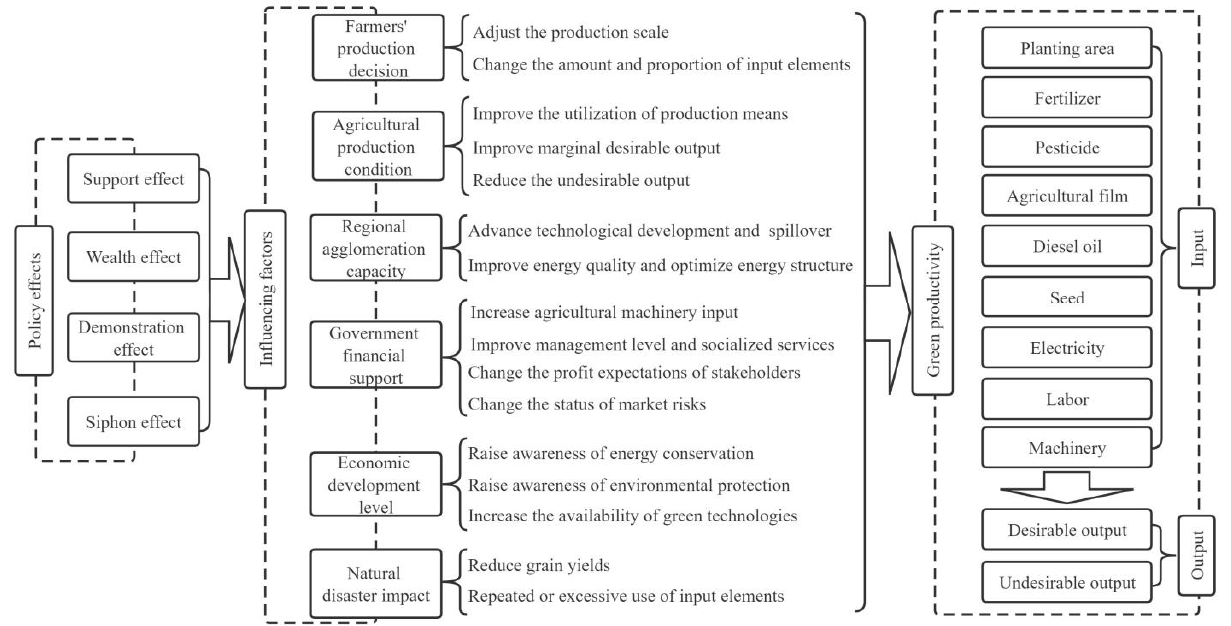
Figure 1. Influence mechanism and policy effects.